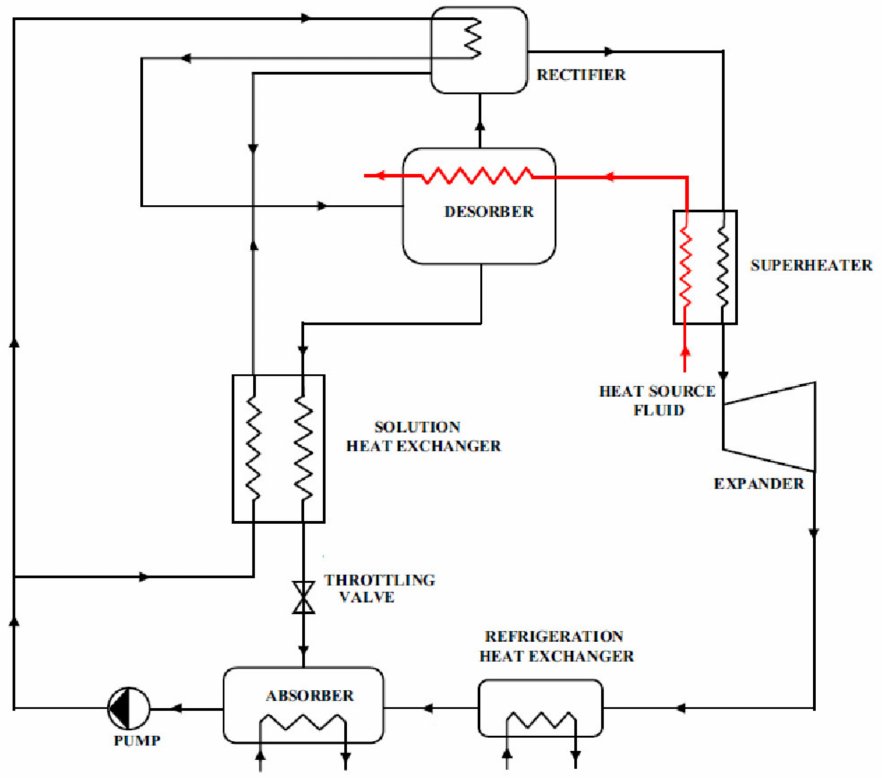
Figure 2. Schematic diagram of an APC system (Goswami cycle) with water/ammonia as working fluid. Adapted from